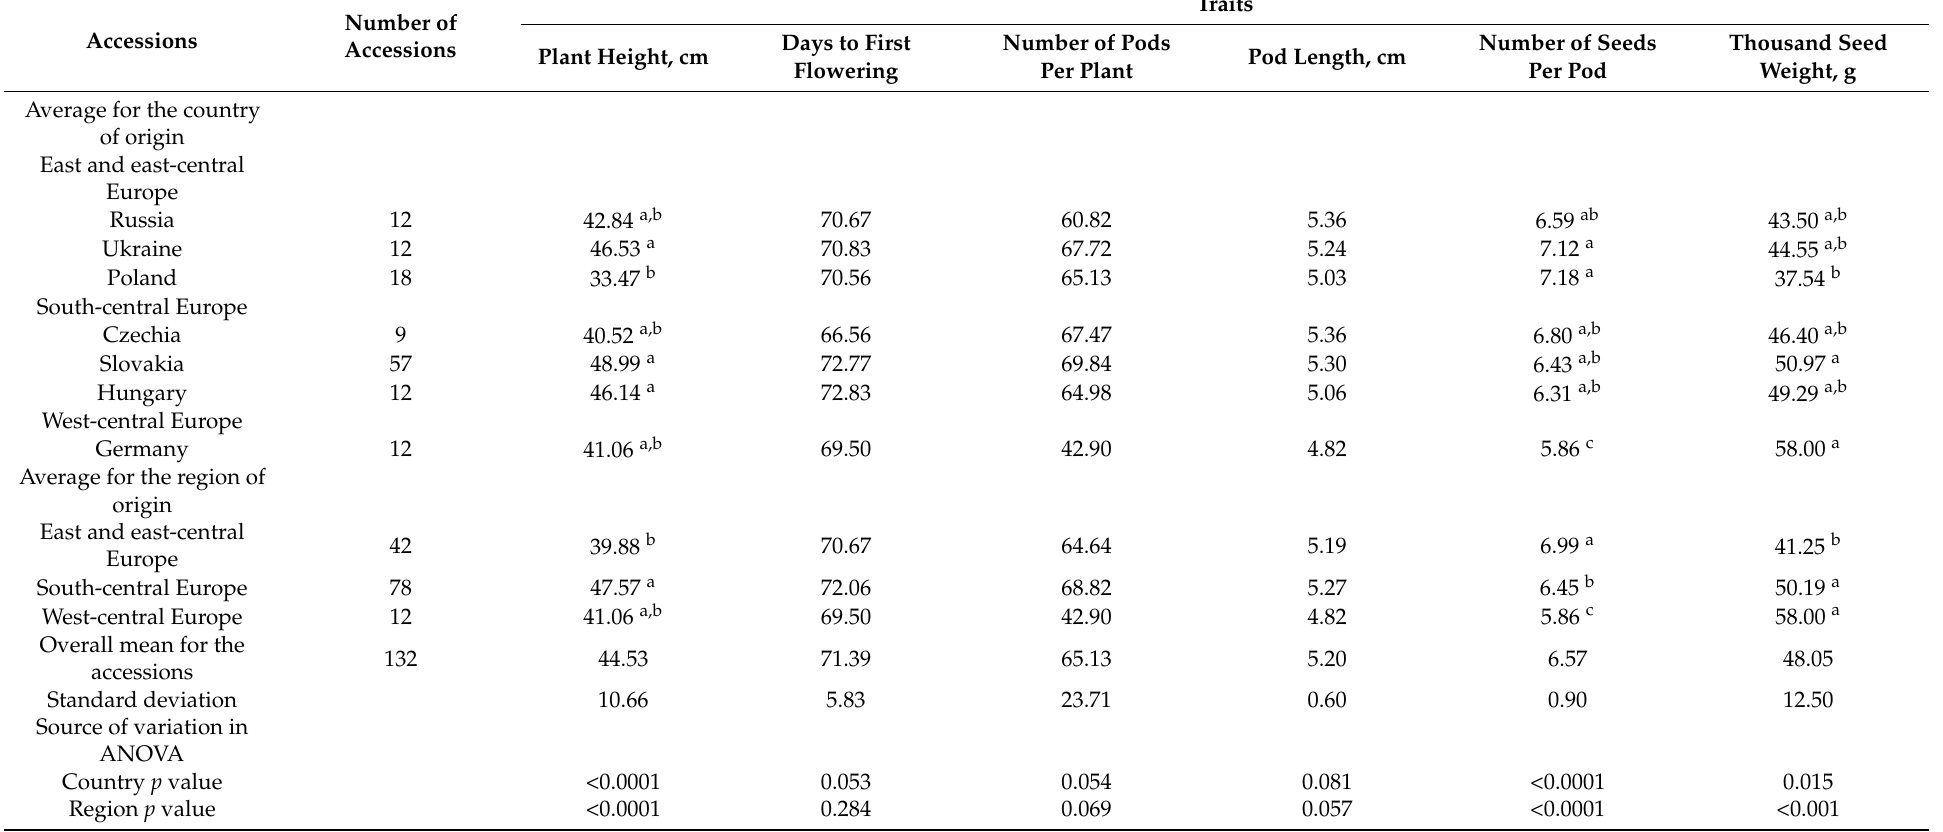
Table 1. Average quantitative phenotypic and morphological traits of Vicia sativa L. accessions originating from different European regions and